Question: What visual encoding does this figure use to show its data?
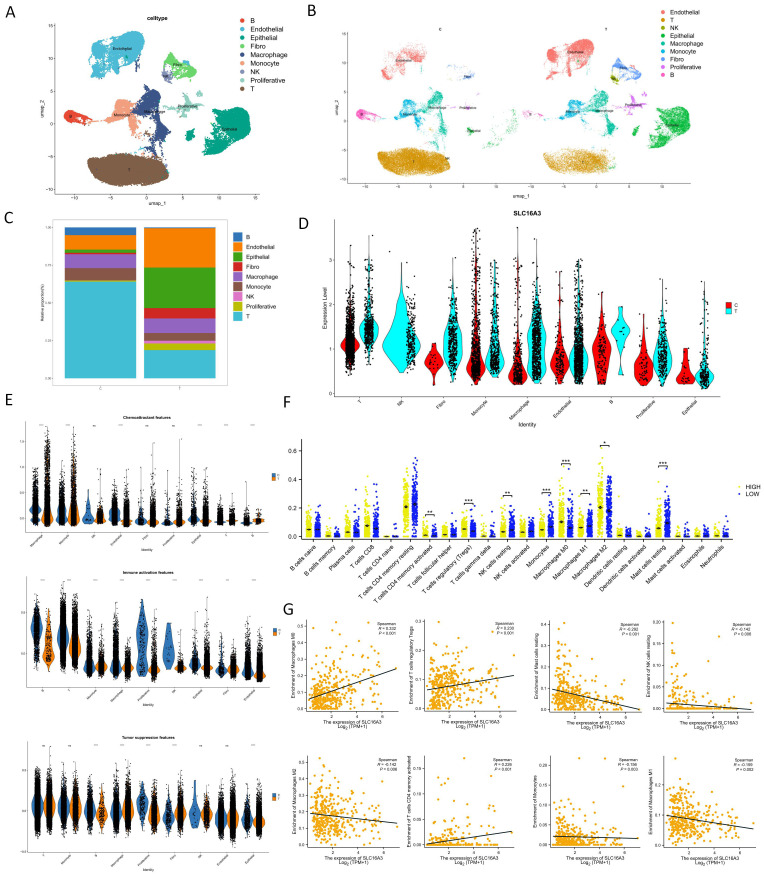
Answer: scatter